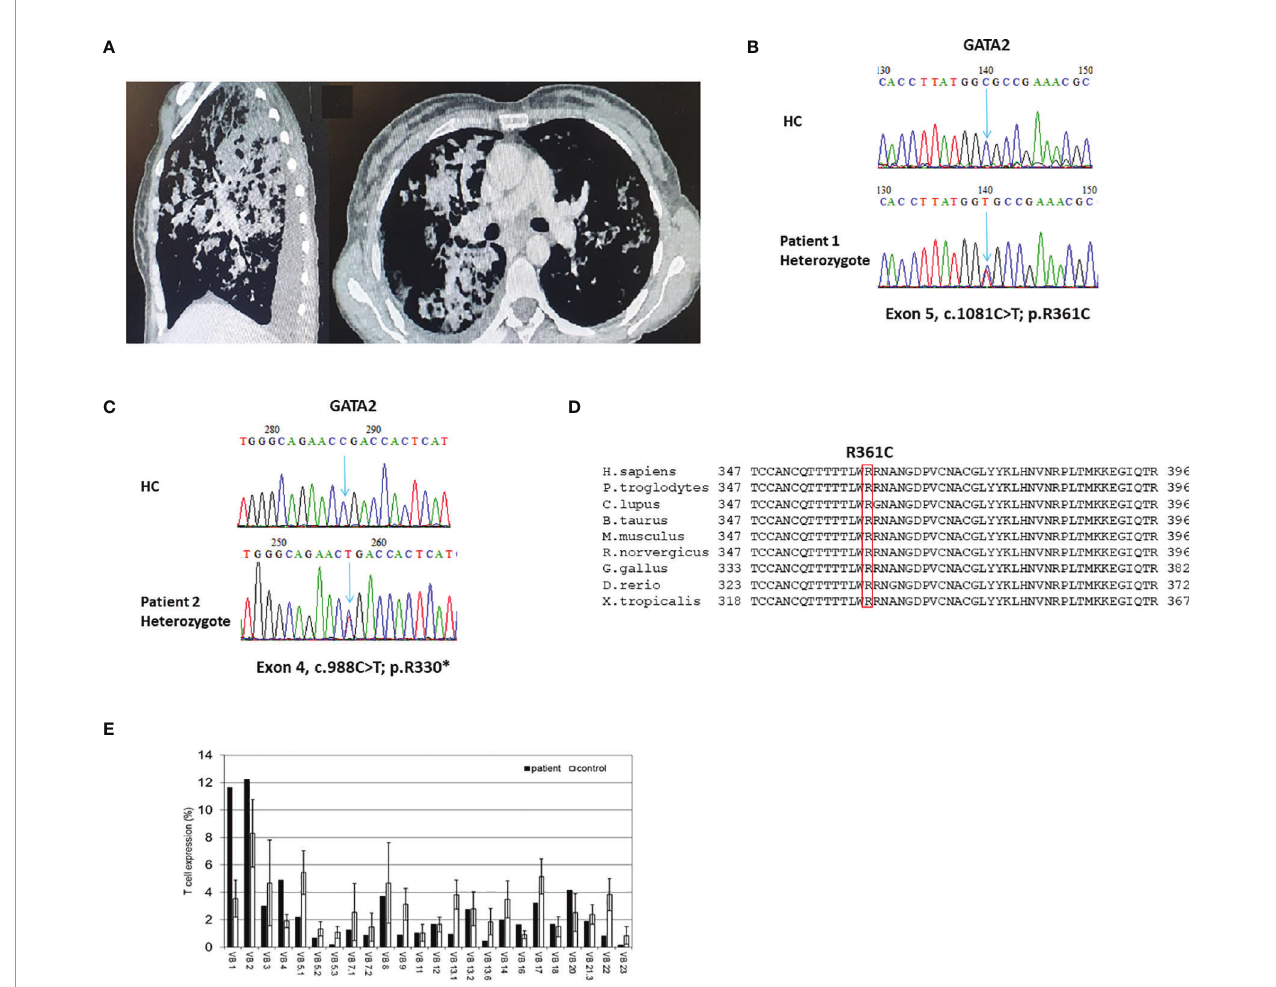
FIGURE 1 | Clinical, genetic, and immune characteristics ofGATA2 de fi ciency. (A) Sagittal and axial images of chest computed tomography scan of patient (P)1. Noted are bilateralconsolidationsconstituting a radiological picture compatiblewith pulmonary alveolar proteinosis; (B, C) Sanger sequencing validation ofthe GATA2 heterozygote variants found inexome sequencing analyses of P1 (B) and P2 (C) . HC – Healthy Control. (D) Multiplesequence alignment of the GATA2 aminoacid region containingthe conservedhuman mutated Arginine 361 residue (boxed inred) of P1 across different species. H.sapiens-Human;P.troglodytes, Chimpanzee; C.lupus, ;Wolf; B.taurus, Cattle; M.musculus, Mouse; R.norvergicus, Rat; G.gallus, Chicken;D.rerio, Zebra fi sh;X.tropicalis, Frog. (E) T-cellreceptor v- b repertoire fl ow cytometryanalysis of P1. A polyclonalrepertoire can beseen with clonal expansionsof v b 1 andv b